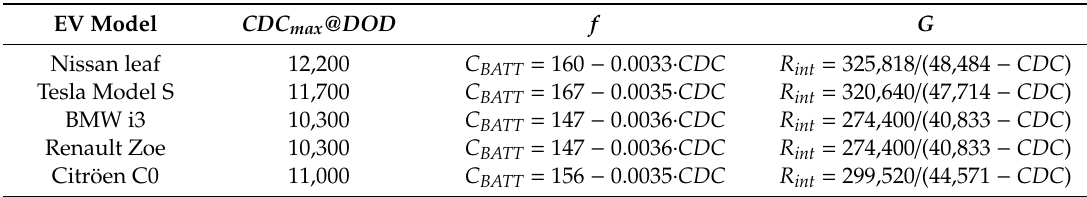
Table 10. C BATT and R int aging approximation—CSs with dedicated II-Life ESS.